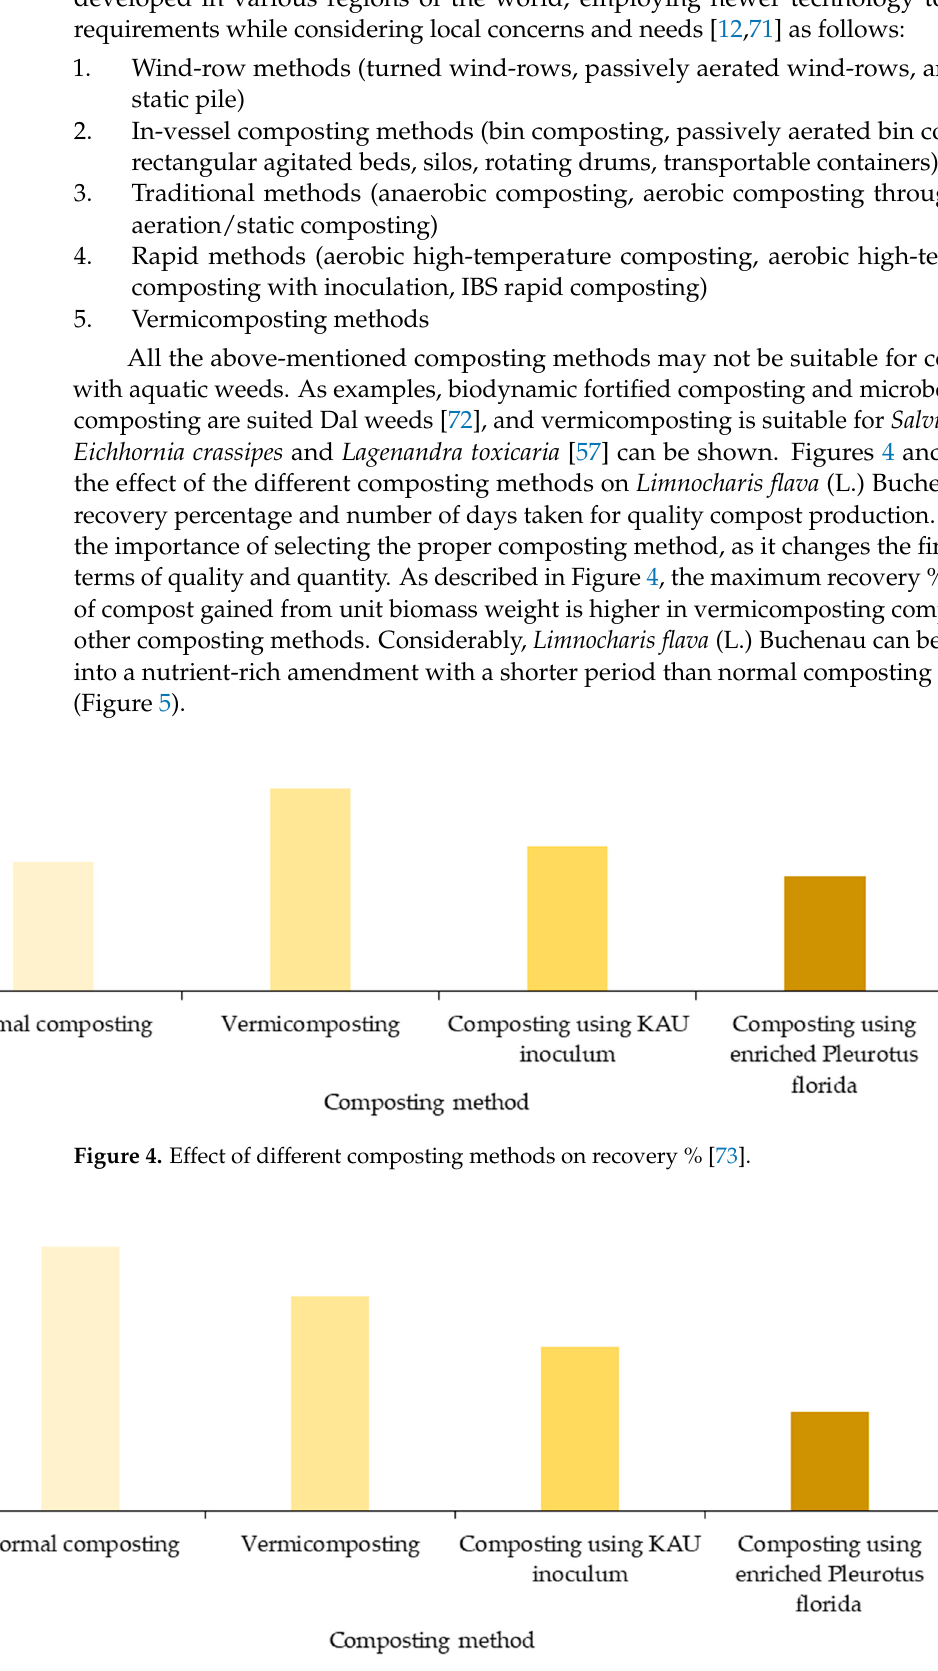
Figure 5. Effect of different composting methods on time taken for composting [73].